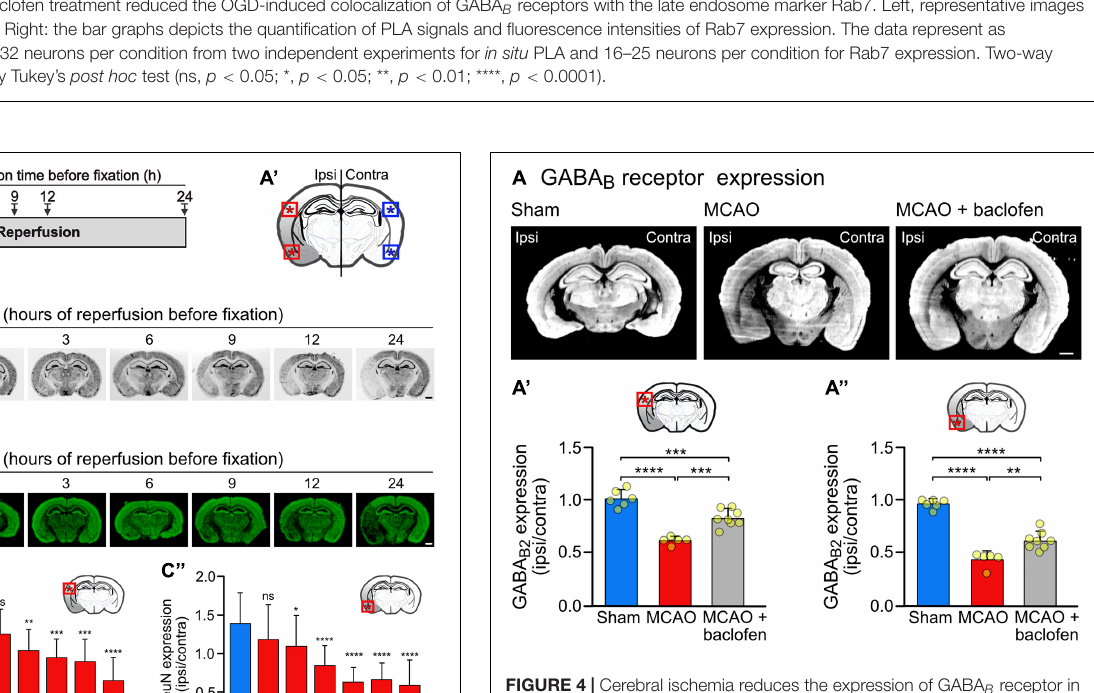
FIGURE 4 | Cerebral ischemia reduces the expression of GABA B receptor in the neocortex. Mice were subjected to Sham or MCAO surgery and instantly thereafter injected with baclofen (i.p., 25 mg/kg) or saline, followed by 6 h reperfusion. (A) Representative coronal sections depicting the expression of GABA B receptors (scale bar, 1 mm). (A (cid:48) ) Quantification of the fluorescence intensities in the ipsilateral dorsal cortex normalized to the corresponding contralateral side. (A (cid:48)(cid:48) ) Quantification of the fluorescence intensities in the ipsilateral ventral cortex normalized to the corresponding contralateral side. The data represent the mean ± SD of slices/mice obtained from: sham = 43/6; MCAO = 39/5; MCAO + Baclofen = 60/8. The data points represent the average fluorescence intensity derived from all slices analyzed per mouse. One-way ANOVA followed by Tukey’s Multiple Comparison test (**, p < 0.01; ***, p < 0.001; ****, p <